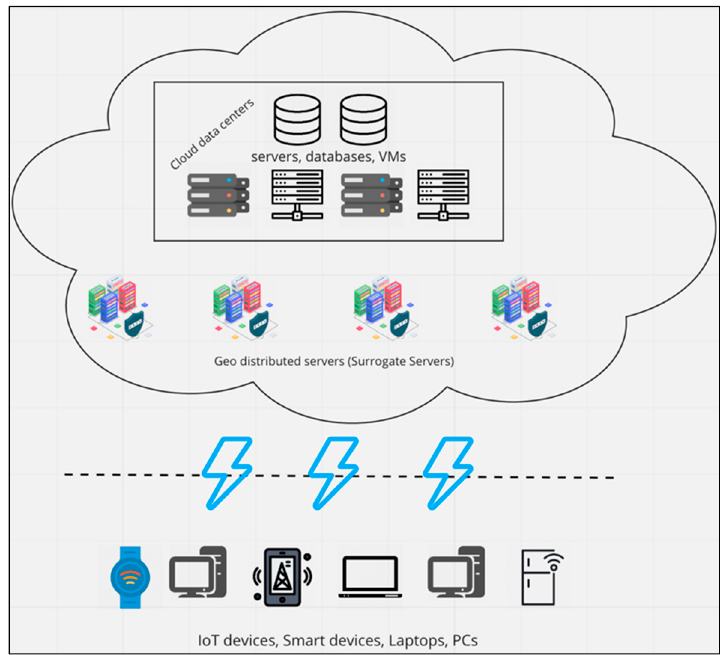
Figure 1. CDN abstract architecture.